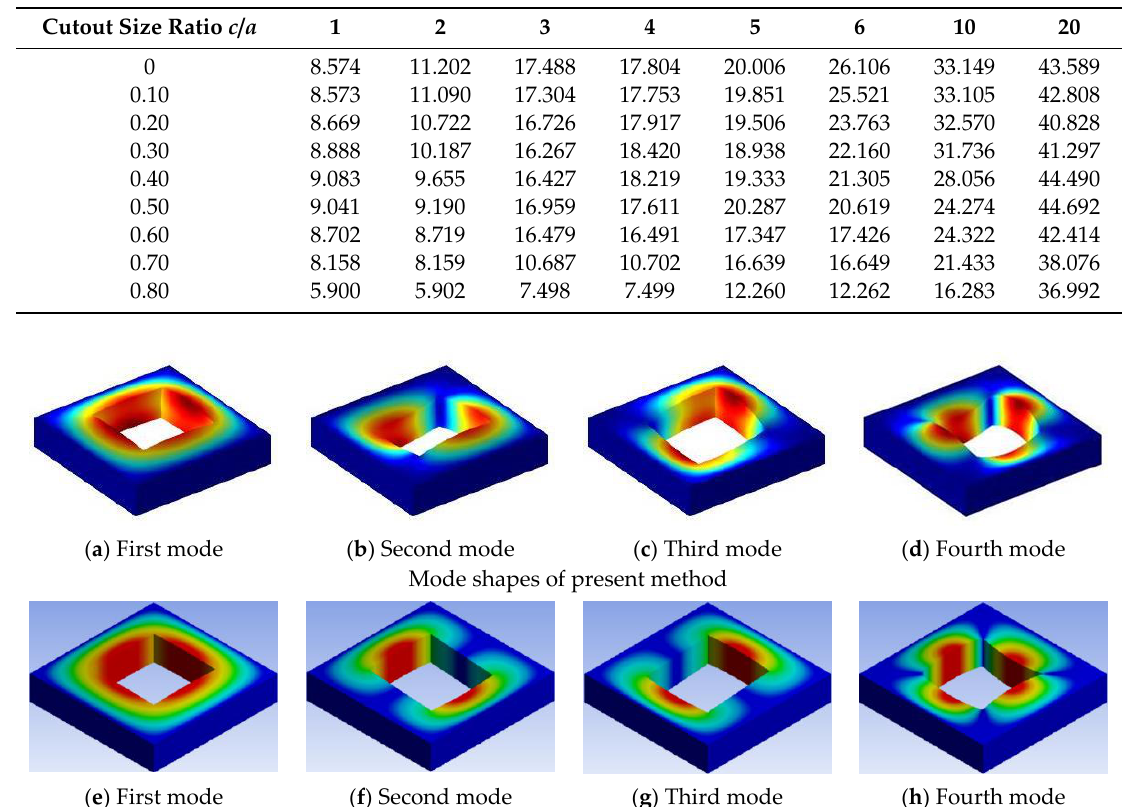
Table 9. Some of the first 20 frequency parameters Ω of angle-ply (45 ◦ / − 45 ◦ / 45 ◦ / − 45 ◦ ) laminated square plate with di ff erent cutout sizes under CFCF boundary condition.